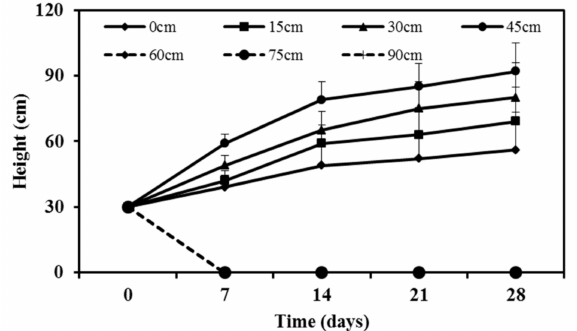
Figure 6. Responses of seedlings’ height of Typha angustifolia to submergence depth over one month in a pond experiment. Submergence depths: 0 cm; 15 cm; 30 cm; 45 cm; 60 cm; 75 cm; 90 cm. The bar indicates ± standard